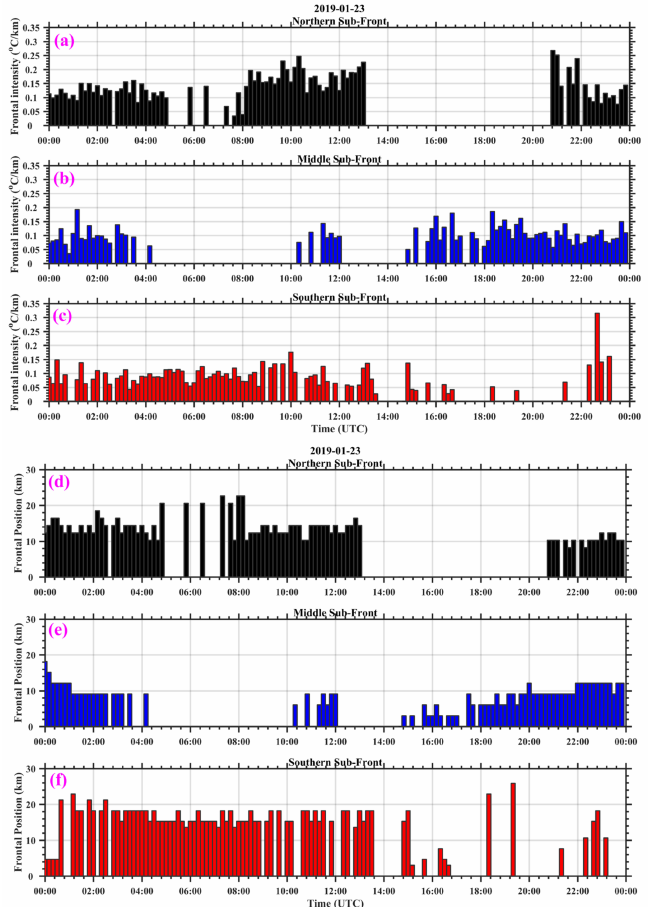
Figure 7. Time series of spatially averaged GMs ( a – c ); frontal positions of maximum JS frontal values ( d – f ) across three transects (Figure 4a) for 23 January